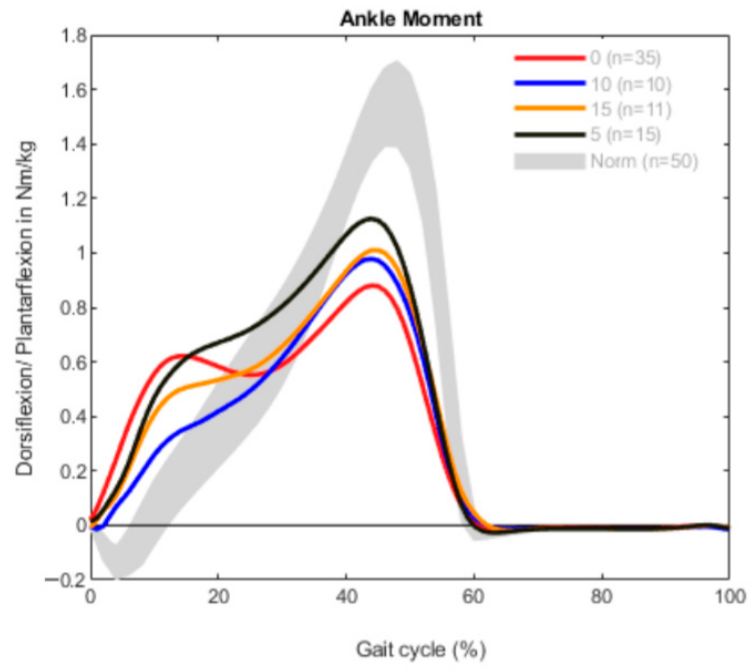
Figure 4. Range of motion measurement in the unilateral group ( n = 71).